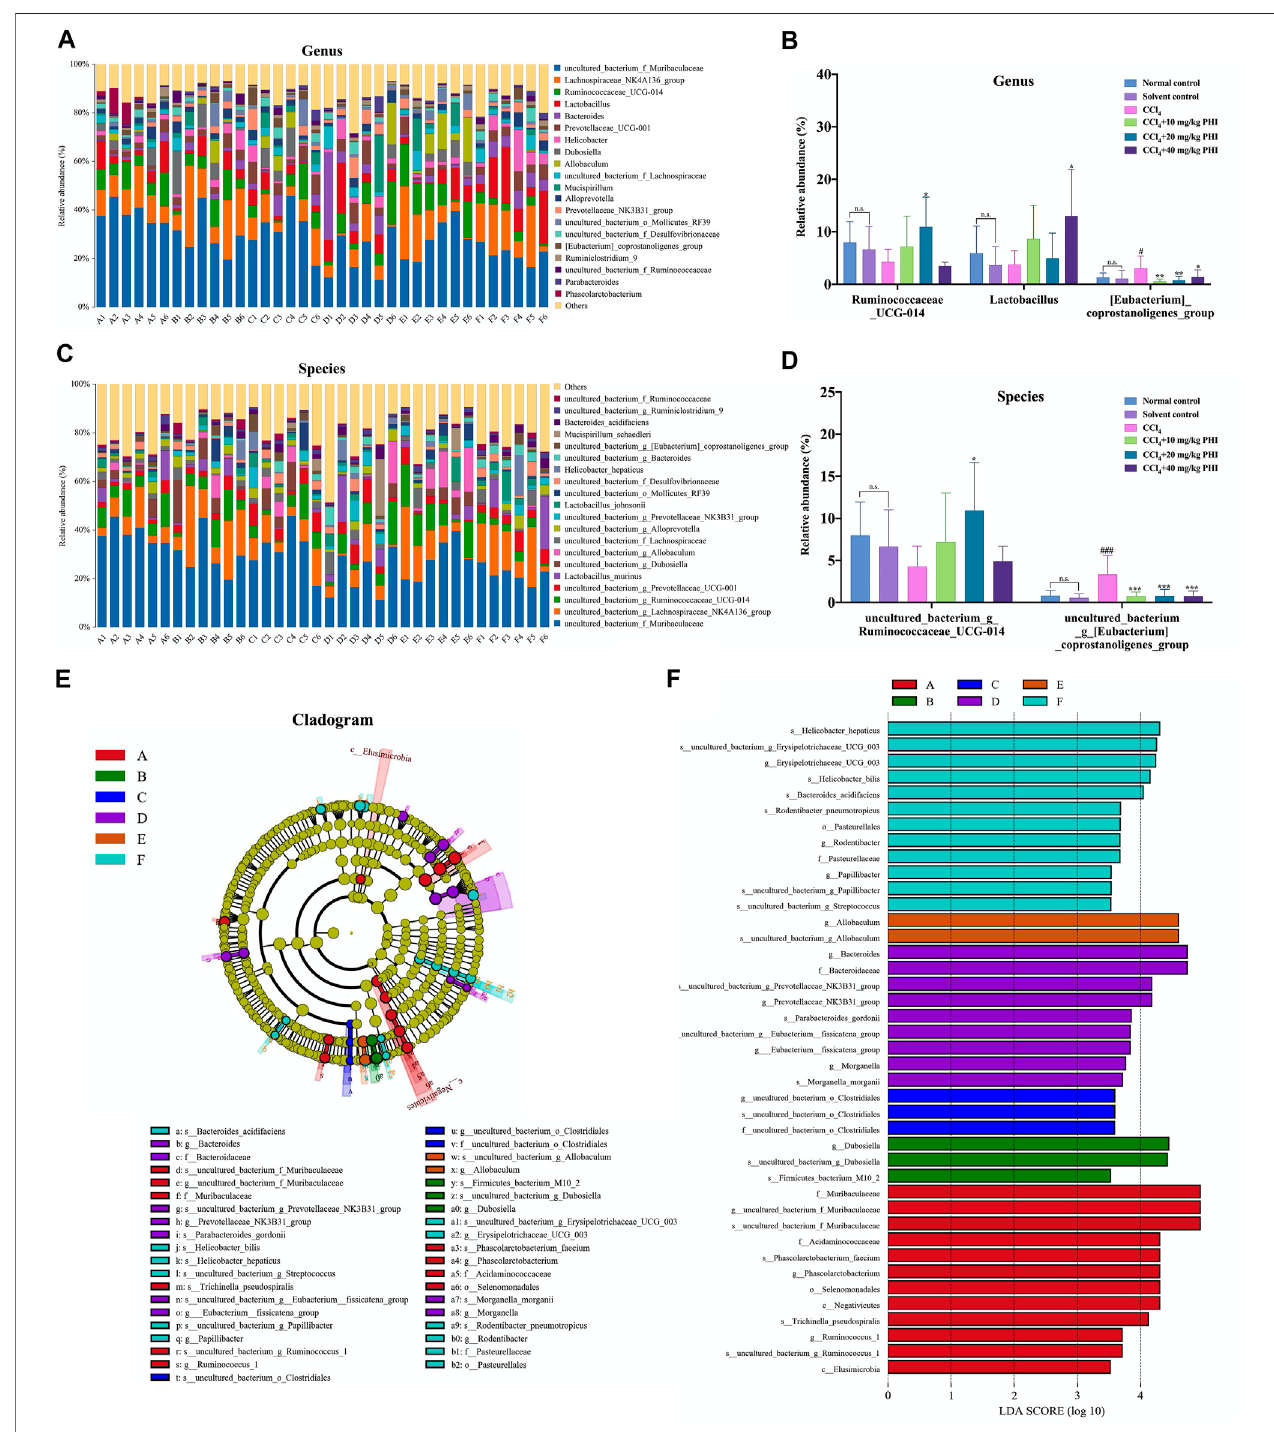
FIGURE8| PHImodulatesthecompositionofgutmicrobiota. (A) Therelativeabundanceofthetop20abundantbacteriaatthegenuslevel. (B) Atthegenuslevel, changes in microbiota in mice in each group. (C) The relative abundance of the top 20 abundant bacteria at the species level. (D) At the species level, changes in microbiota in mice in each group. (E) Linear discriminant analysis effect size (LEfSe) prediction was used to identify the most differentially abundant bacteria in each group. (F) LDA scores showed signi fi cant bacterial differences in each group. Only the bacteria meeting a signi fi cant LDA threshold value of 3.5 are shown. A: Normal control; B:Solventcontrol; C:CCl 4 ;D:CCl 4 +10 mg/ kg PHI;E:CCl 4 +20 mg/ kgPHI;F: CCl 4 +40 mg/ kgPHI.Datawasexpressed asthemean ± SD( n (cid:1) 6). # p < 0.05, ### p < 0.001 represent compared with solvent control group. * p < 0.05, ** p < 0.01, *** p < 0.001 represent compared with CCl signi fi